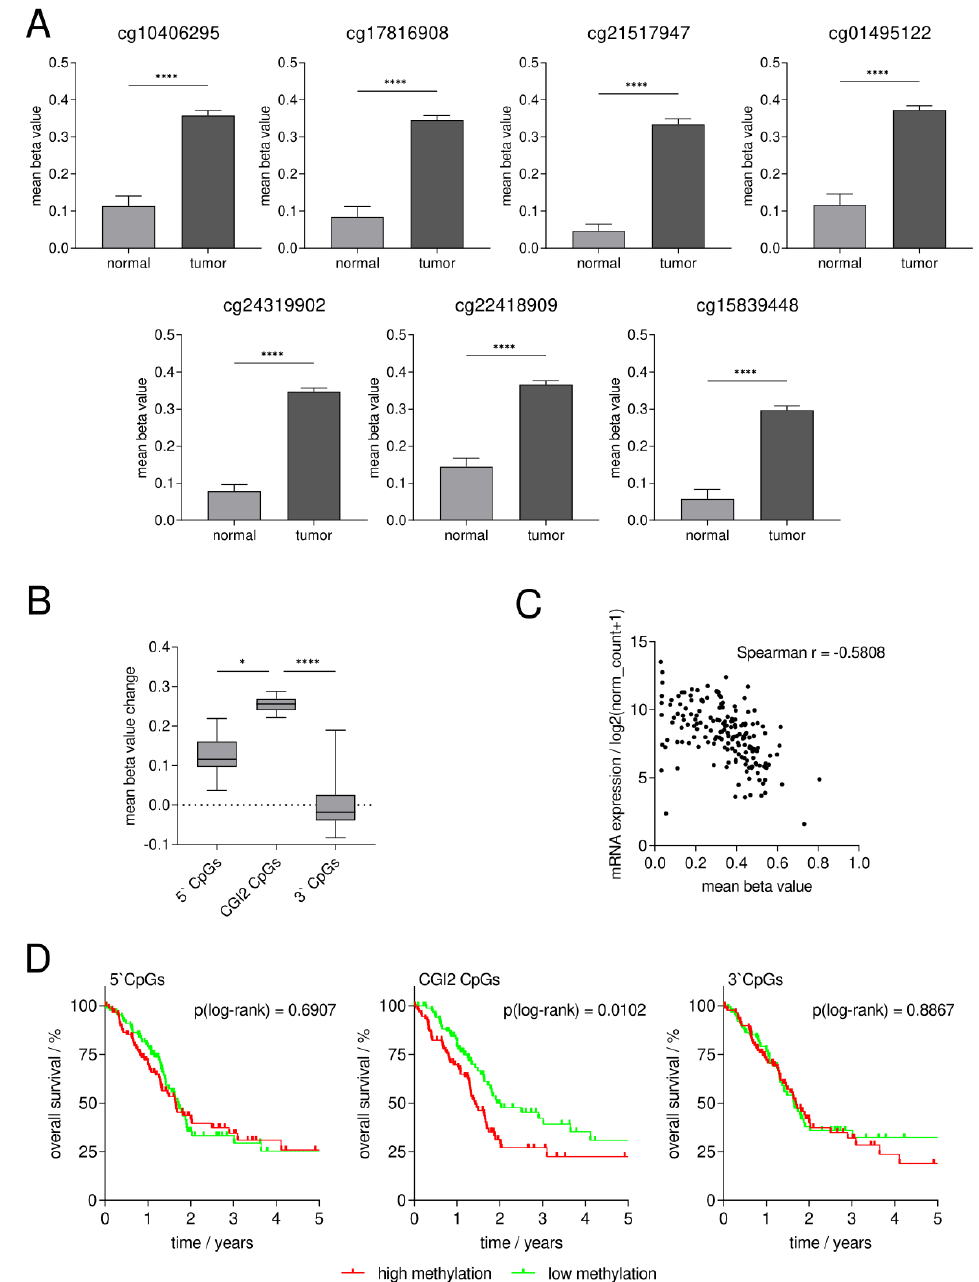
Figure 2. In silico analysis of SFRP1 promoter methylation in primary pancreatic cancer shows significantly higher DNA methylation at specific CpG sites (CGI2) in tumor vs. normal tissue with potential clinical impact. ( A ) Mean methylation status of all specific CpG sites is significantly higher in tumor ( n = 184) vs. normal tissue ( n = 10) (Mann–Whitney U test, **** p < 0.0001). ( B ) Mean methylation change of CGI2 CpGs is significantly higher than that of 5’CpGs (Dunn’s test, * p < 0.05) and 3’CpGs (Dunn’s test, **** p < 0.0001). ( C ) Inverse correlation of mean CGI2 CpGs methylation status and SFRP1 mRNA expression in primary pancreatic tumors ( n = 178, Spearman r = − 0.582). ( D ) Kaplan–Meier analysis in dependence of pancreatic cancer patients’ overall survival and their SFRP1 DNA methylation status dichotomized by the median in high (red) and low (green) methyla- tion. Left and right: no significant difference of overall survival between high vs. low methylation status of 5’CpGs (median beta value = 0.31, log-rank test, ns p = 0.6907) and 3’CpGs (median beta value = 0.56, log-rank test, ns p = 0.8867). Middle: significantly longer overall survival with low vs. high methylation status of CGI2 CpGs (median beta value = 0.37, log-rank test, * p =